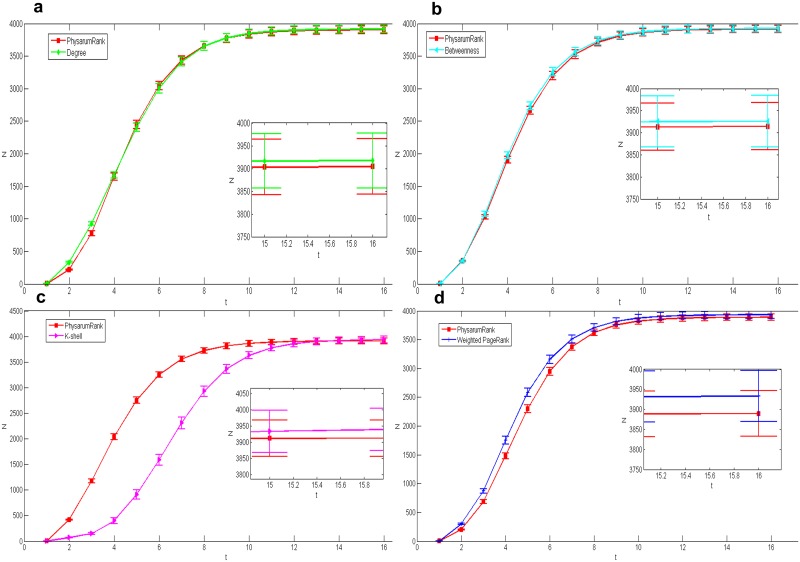
Comparison of epidemic spreading efficiency among different measures when L = 50, in collaborations network network.Each result N is obtained by averaging over 100 implementations with α = 0.2 and β = 1. (a):PhysarumSpreader vs Degree, n = 29. (b):PhysarumSpreader vs Betweenness, n = 43. (c):PhysarumSpreader vs K-shell, n = 47. (d):PhysarumSpreader vs Weighted PageRank, n = 27.